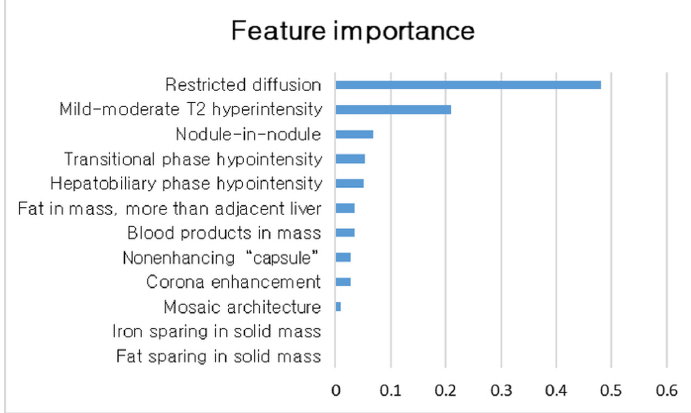
Figure 1. Ranking of feature importance. Table 2. Distribution of ancillary features favoring malignancy between HCC and non-malignant nodule.